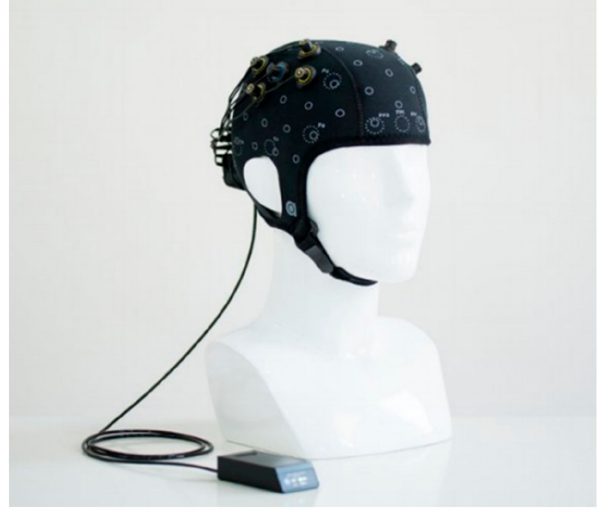
Figure 8. An fNIRS imaging cap designed and built by Artinis for use of monitoring the hemo- dynamic response. (Reprinted from Artinis OctaMon, with permission from Artinis Medical Systems. Copyright 2021. Available online: https://www.artinis.com/octamon accessed on 12 September 2021).